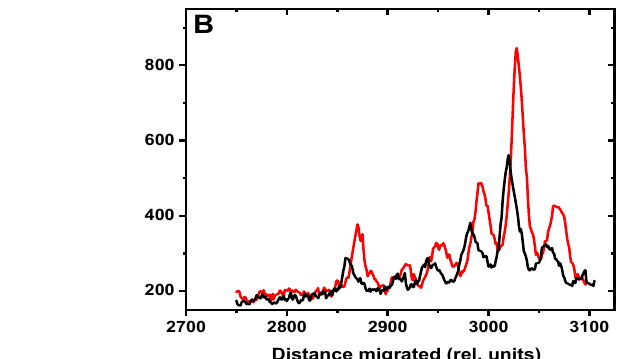
Figure 5. BP-dG adduct sample. Example of a densitometry scans of the 30 min incubation time lane derived from BRBE-pretreated (red trace) and untreated (black trace) HeLa cell extract NER product profile (data from Figure 4. Panel ( A ): Trace of the entire lane, from top to the bottom of the gel. Panel ( B ): × 100 amplification of the lower region of the lanes containing the ~24–30 nt oligonucleotide dual incision NER excision products (Figure 4).